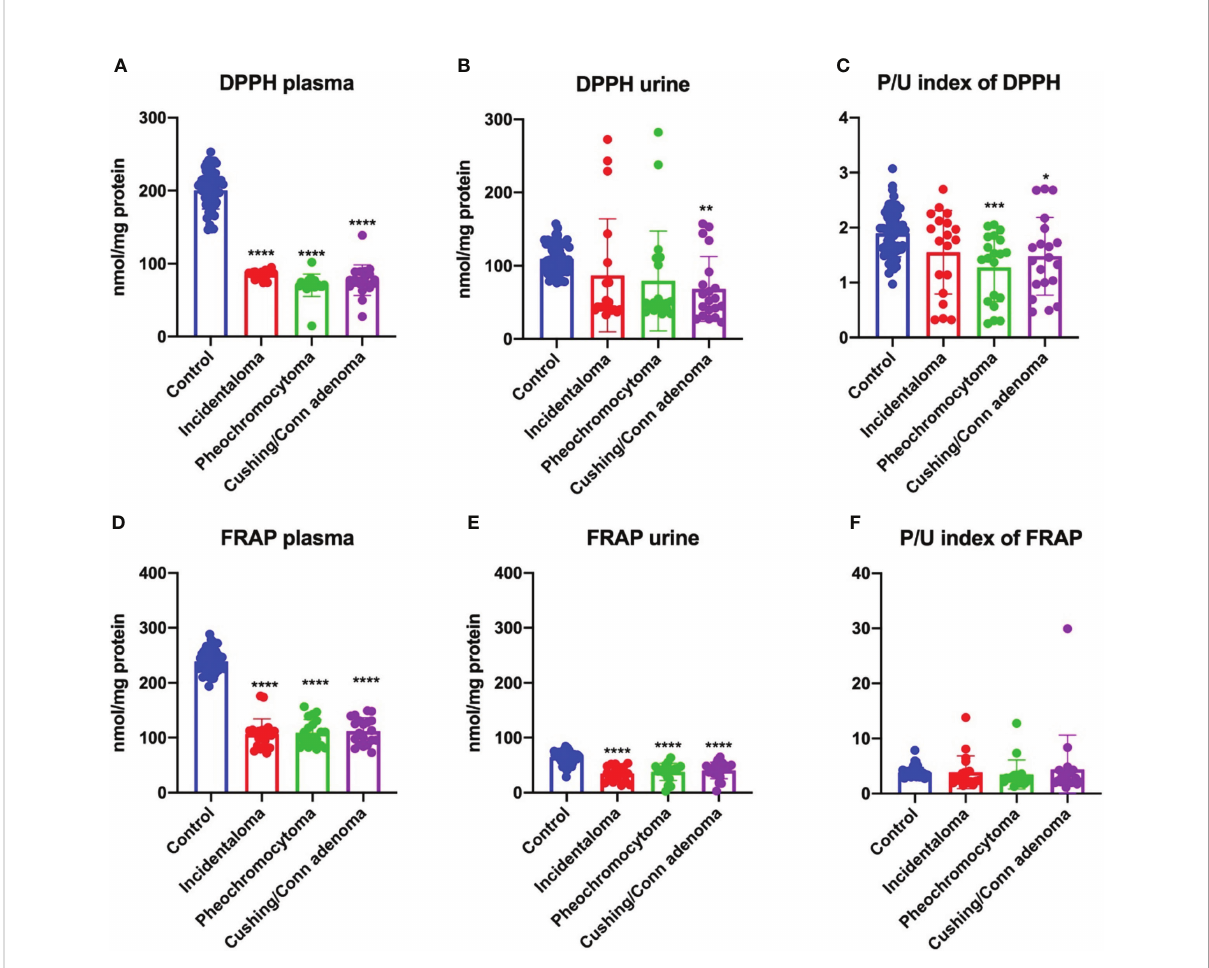
FIGURE 2 Plasma DPPH (A) and FRAP (D) , urine DPPH (B) and FRAP (E) , and plasma/urine index of DPPH (C) and FRAP (F) of the controls, incidentaloma, pheochromocytoma, and Cushing ’ s/Conn ’ s adenoma patients. Results are presented as mean with standard deviation. *p<0.05, **p<0.01, ***p < 0.001, ****p < 0.0001 indicate signi fi cant differences from the controls; 2,2 ′ -diphenyl-1-picrylhydrazyl radical (DPPH) and ferric reducing antioxidant power